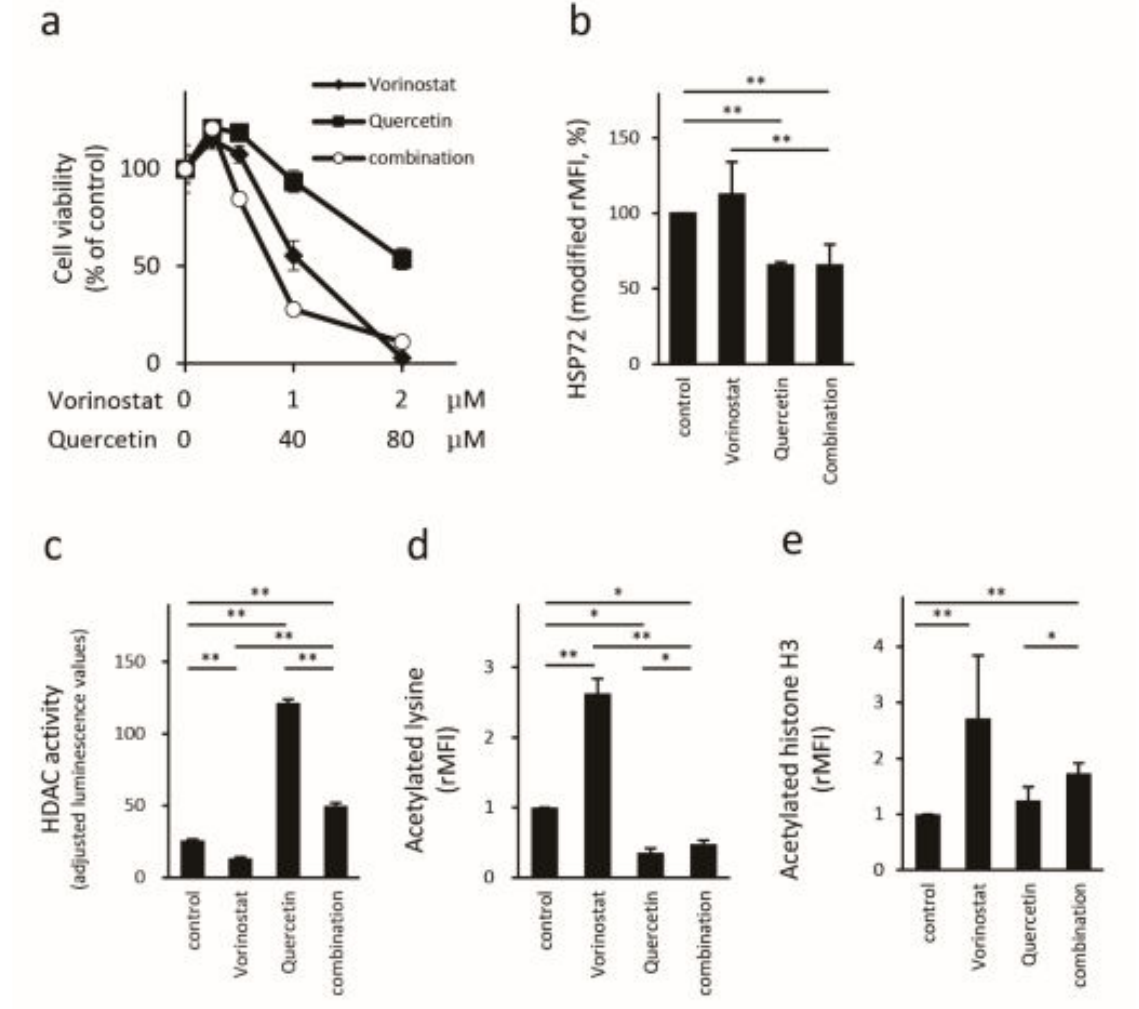
Figure 3. Influence of quercetin on vorinostat-treated Hut78 cells. Cell proliferation was assessed by WST-1 assays (( a ), n = 4).